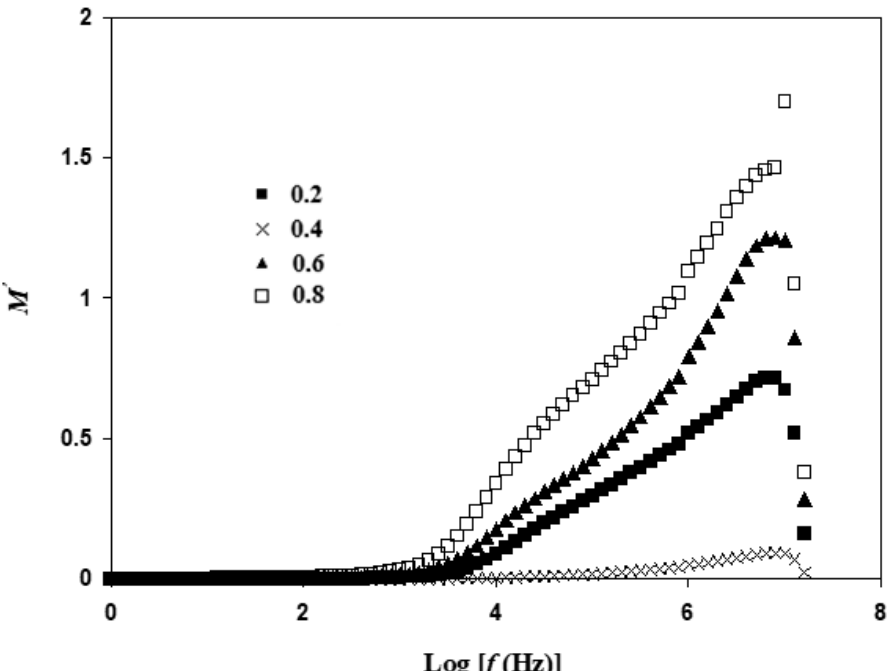
Figure 10. Variation of M ′ at different frequencies for Li 1+x Al x Ti x Sn 2 − 2x (PO 4 ) 3 at sintering tempera- ture of 650 °C.